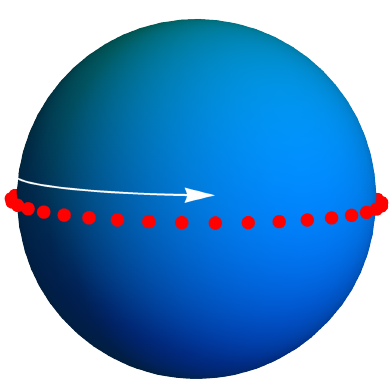
Figure 3 . In the large spin limit, the minimal dimension operator(s) can be thought of as Q partons rotating on the equator of the sphere. When J/Q 2 ∼ 1 these partons should collapse to the giant